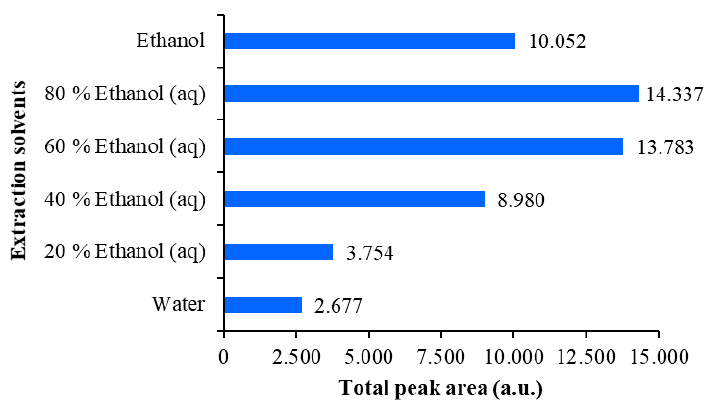
Figure 6. Comparison of the total peak areas obtained from densitograms of Japanese knotweed rhizomes STSs scanned at 442 nm on the HPTLC silica gel plate developed with toluene–acetone-formic acid (3:6:1, v / v ). STSs (2 μ L, 50 mg/mL) were prepared with water, 20% ethanol (aq) , 40% ethanol (aq) , 60% ethanol (aq) , 80% ethanol (aq) and ethanol.